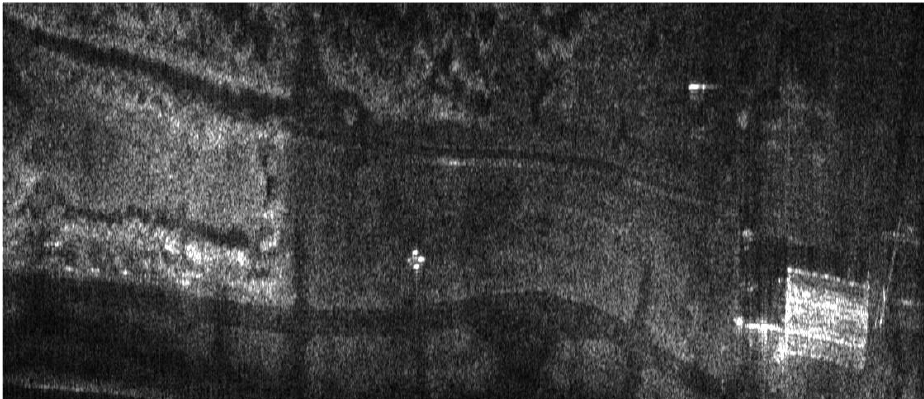
Figure 11. Radar terrain image obtained without navigation correction.